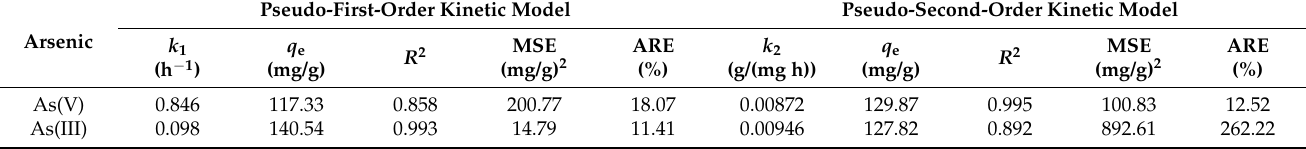
Table 1. Adsorption kinetic parameters for As(V) and As(III) adsorption onto MnO 2 @La(OH) 3 nanocomposite at pH